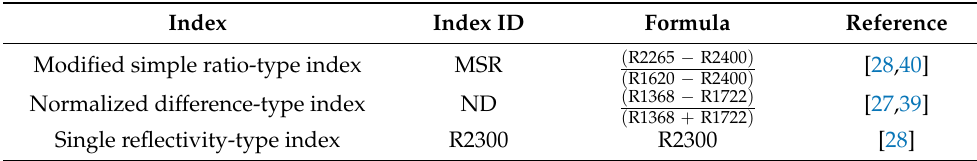
Table 2. Spectral indices constructing the first 3D